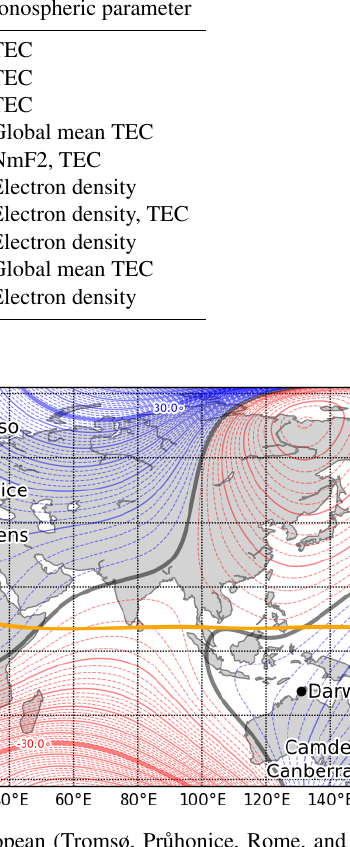
Figure 1. The European (Tromsø, Pr˚uhonice, Rome, and Athens) and Australian (Darwin, Camden, and Canberra) ionosonde stations which are used in the calculation of the delayed response of the ionosphere to solar EUV variations. Earth’s magnetic field is pre- sented with the geomagnetic Equator (orange line) and the magnetic declination (blue, red and black lines) from the World Magnetic Model (NASA,